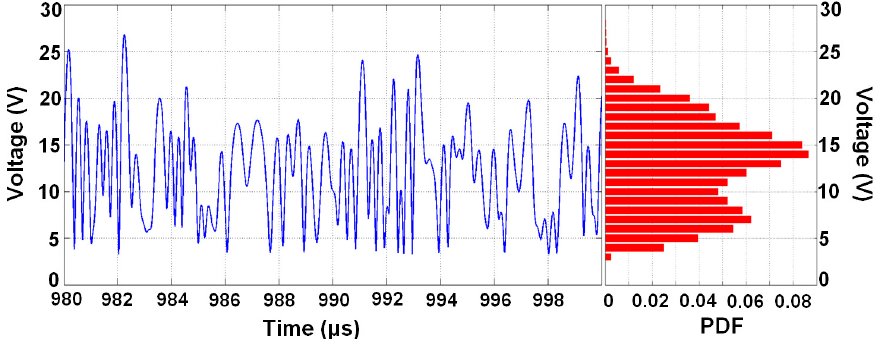
Figure 2. The waveform of the de-troughed envelope signal and correspondent envelope amplitude probability distribution function (PDF).